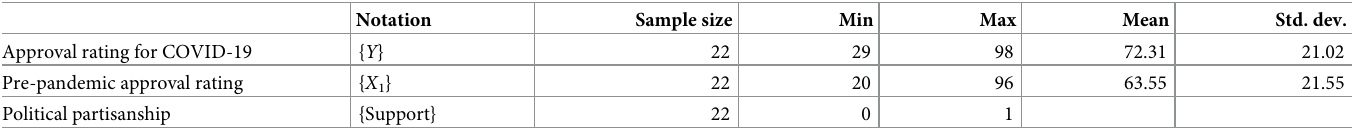
Table 1. Descriptive